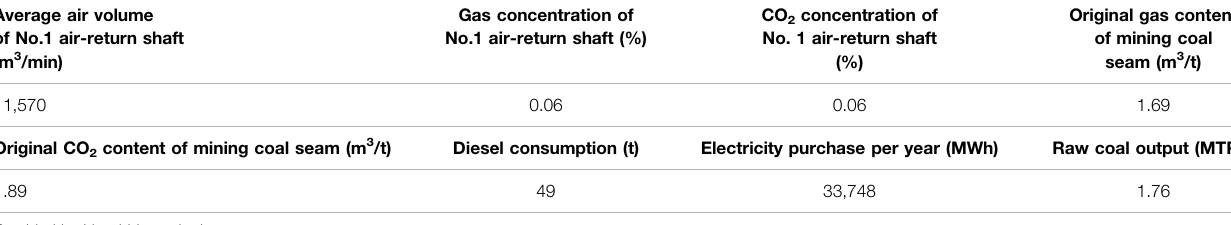
TABLE 2 | Data of carbon emission of Lingzhida coal mine in 2020. Average air volume of No.1 air-return shaft